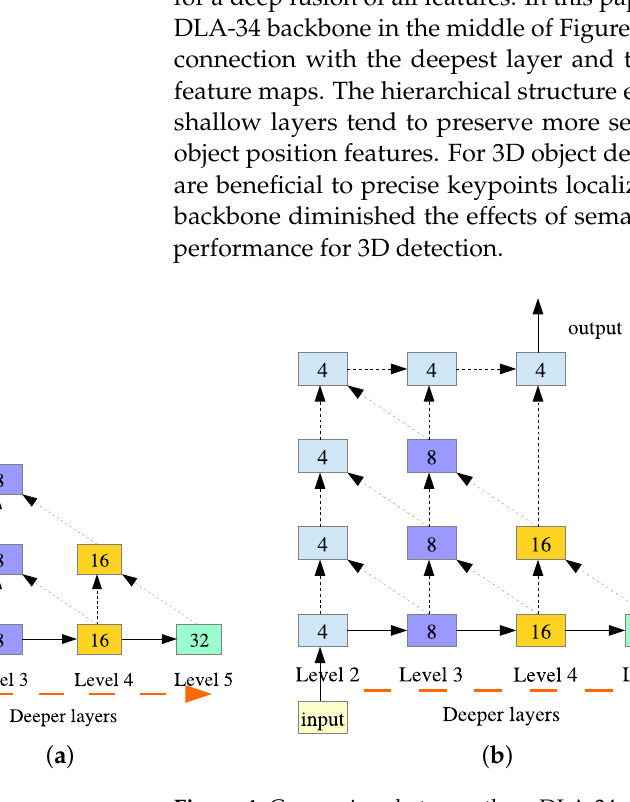
Figure 4. Comparison between three DLA-34 networks with different aggregation strategies. ( a ) The original DLA-34 Backbone. ( b ) The proposed semi-aggregation DLA-34 (SADLA-34) backbone. ( c ) Full-aggregation DLA-34